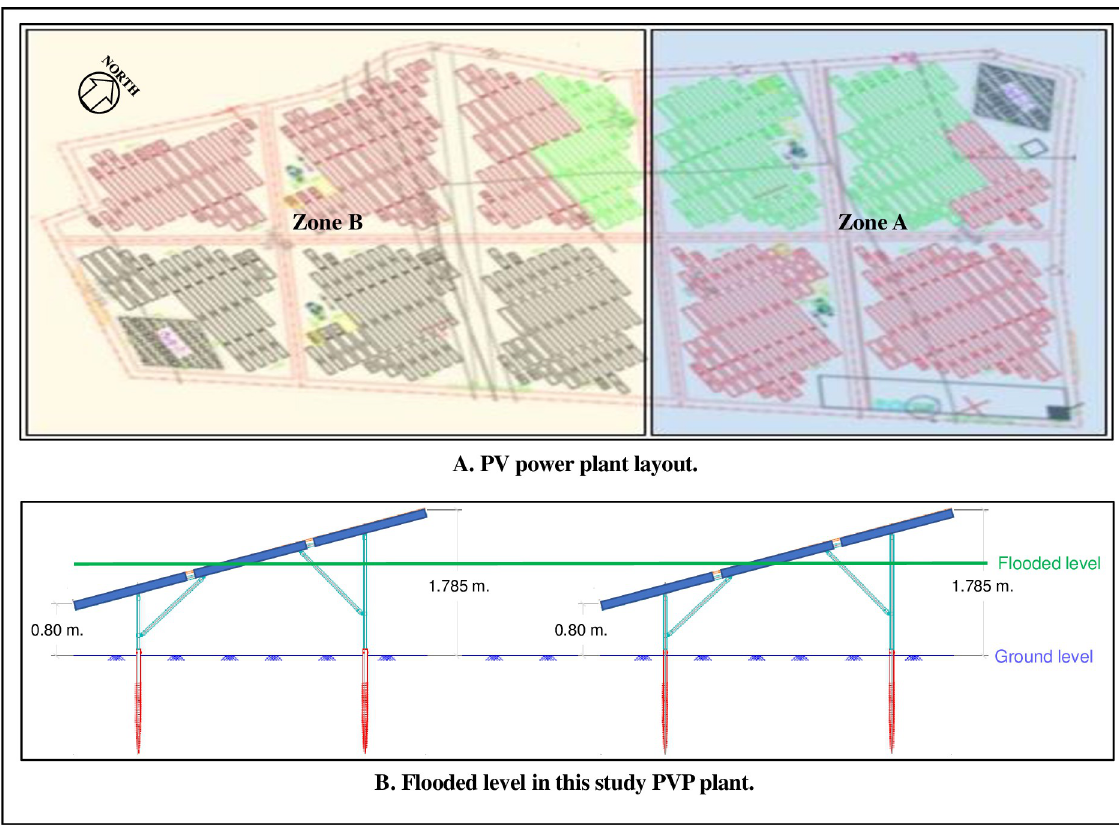
Fig 3. Layout of the PVP plant and the level of flooding. A. PV power plant layout. B. Flooded level in this study PVP plant.